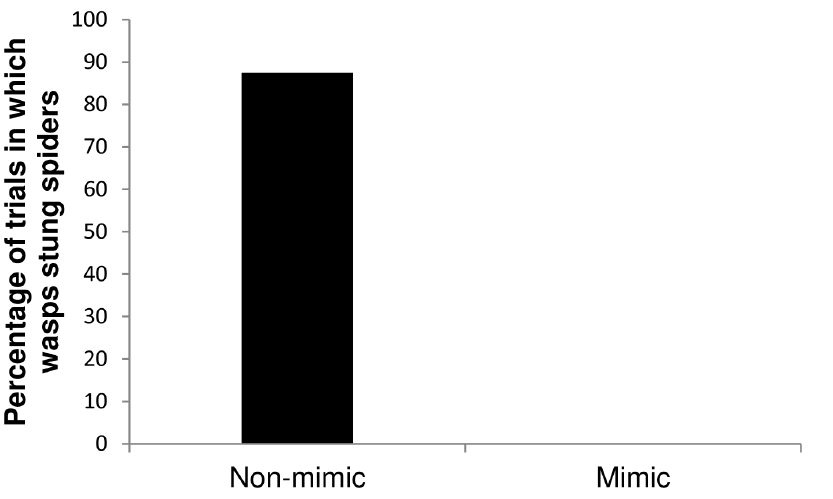
Figure 2. Ant-mimicking spider does not elicit predatory response from chemically-oriented spider-hunting wasps: Sceliphron caementarium wasps readily stung non-mimetic jumping spiders ( Phidippus putnami ) but never stung ant-mimicking spiders ( Peckhamiapicata ) (binomial probability, P=0.035).